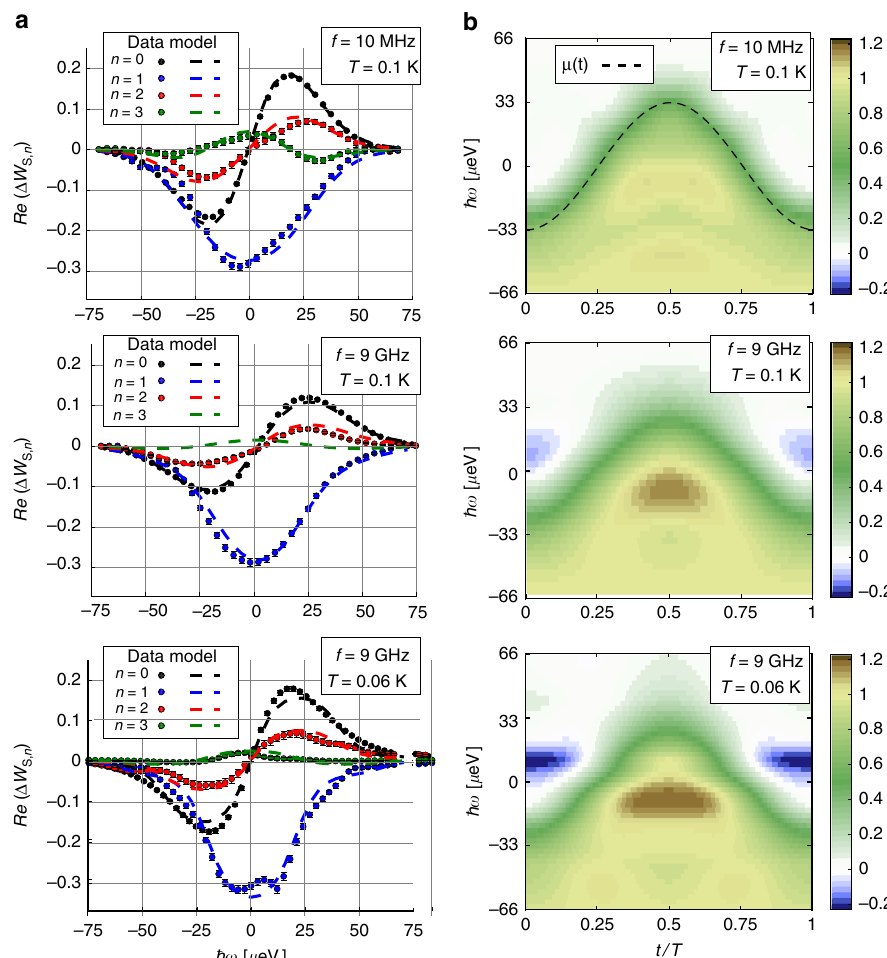
Fig. 3 Wigner distribution of sinusoidal drives. a Measured Δ W S, n ( ω ) for n = 0 to n = 3 for sinusoidal drives at frequency f = 10 MHz and f = 9 GHz. The observed parity: Δ W S, n ( − ω ) = ( − 1) n + 1 Δ W S, n ( ω ), directly stems from the electron/hole symmetry of the sinusoidal drive. Error bars are de fi ned as standard error of the mean. b Time – energy representation of the Wigner distribution W S ( t , ω Figure 4b depicts the moduli of the inter-period coherences between emitted wavepackets for different temperatures (bars represent numerical simulations, circles represent data). When the temperature increases, the occupation probabilities which, in the present case, are very close due to electron/hole symmetry (cid:2) (cid:3) ð e Þ (cid:6) p ð h Þ increase from 0.17 (numerical calculation at T el = 0 p 1 1 K) to 0.25 (60 mK) and 0.27 (100 mK). Coherences between ð ee Þ ð l ≠ 0 Þ and g ð hh Þ ð l ≠ 0 Þ ) also appear and different periods ( g 1 1 ’ 0 : 5 ns at 100 extend over the thermal coherence time ( h = k T B el